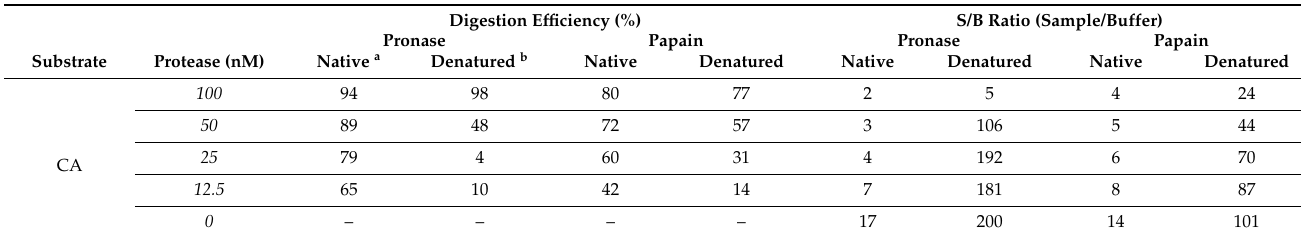
a Non-denatured native sample. b Post-digestion heat denatured sample. c ND refers to less than three-fold TRL-signal increase obtained for the protein substrate compared to protein-probe in buffer, thus deemed to unreliable results.